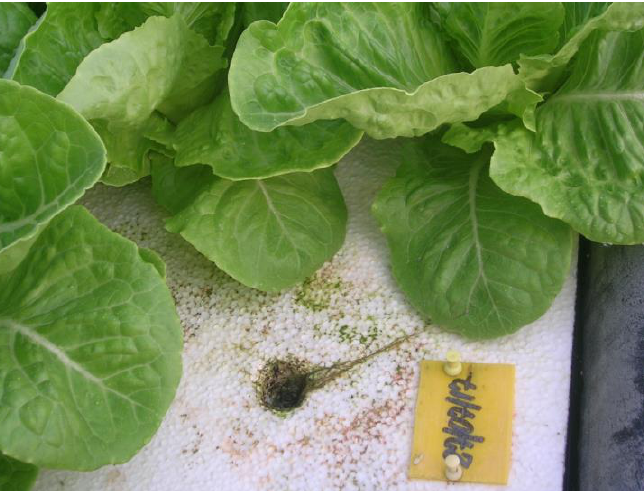
Figure 2. A close-up view of hydroponically grown lettuce showing the Styrofoam floating on the water and some root residues in the empty hole following harvesting of the lettuce head. Photography by E. Shalgi.